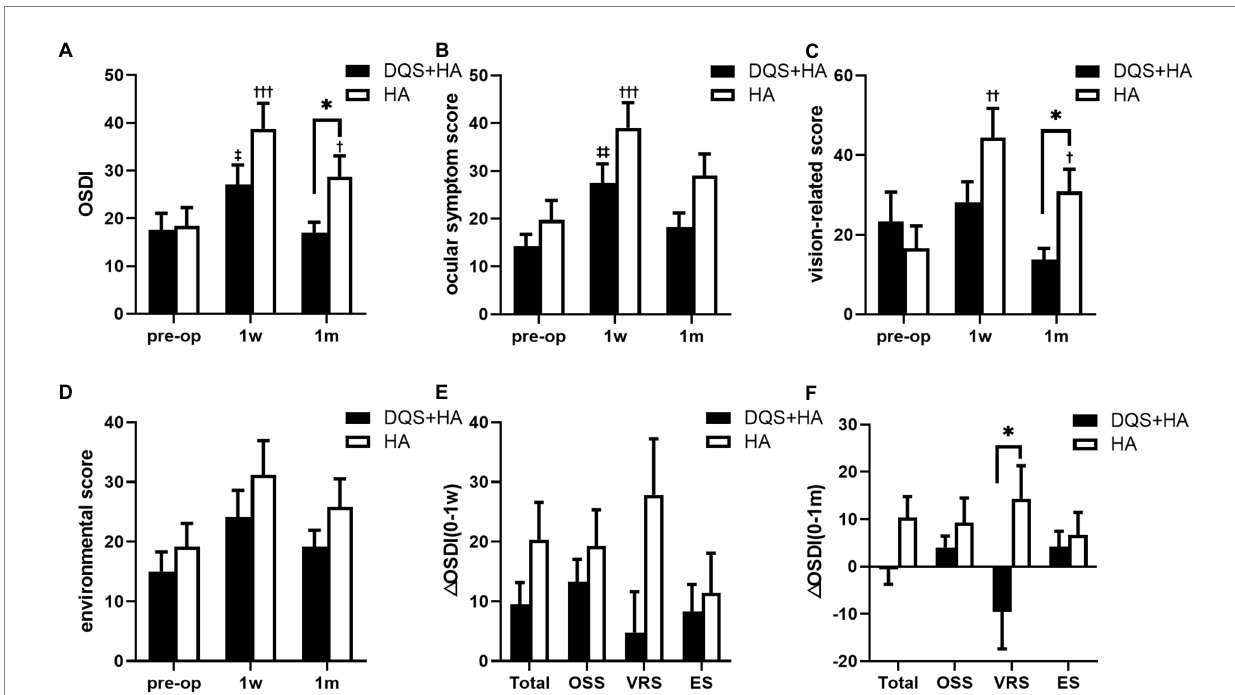
FIGURE 1 Changes in OSDI score (A) , ocular symptom score (B) ,vision-related score (C) , and environmental score (D) in patients after FS-LASIK and the alterations from preoperative to postoperative 1 week (E) and postoperative 1 month (F) . Mean value ± standard error. * p < 0.05 between the combination group and the HA group by independent samples t -test or Mann–Whitney U test. ‡ p < 0.05, ‡‡ p < 0.01 between preoperative visit and postoperative visits in the combination group and † p < 0.05, †† p < 0.01, ††† p < 0.001 between preoperative visit and postoperative visits in the HA group by one-way repeated measures ANOVA or Friedman test. OSDI, ocular surface disease index; OSS, ocular symptom score; VRS, vision-related score; ES, environmental score; DQS + HA, combination of diquafosol tetrasodium and sodium hyaluronate; HA, sodium